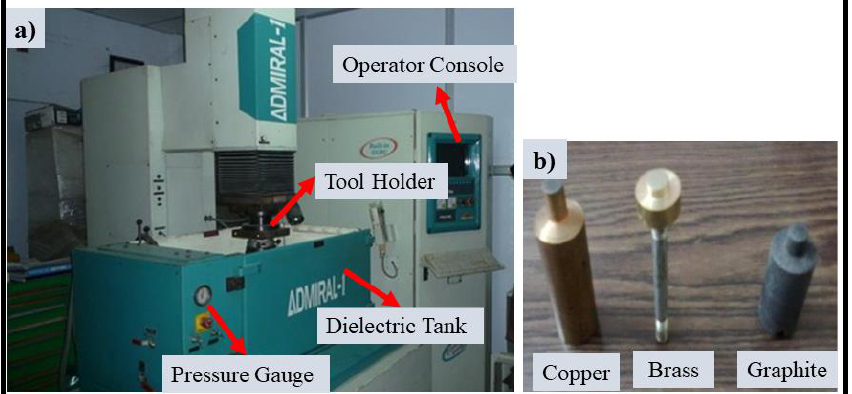
Table 4. Details of electrode materials properties [43–45].